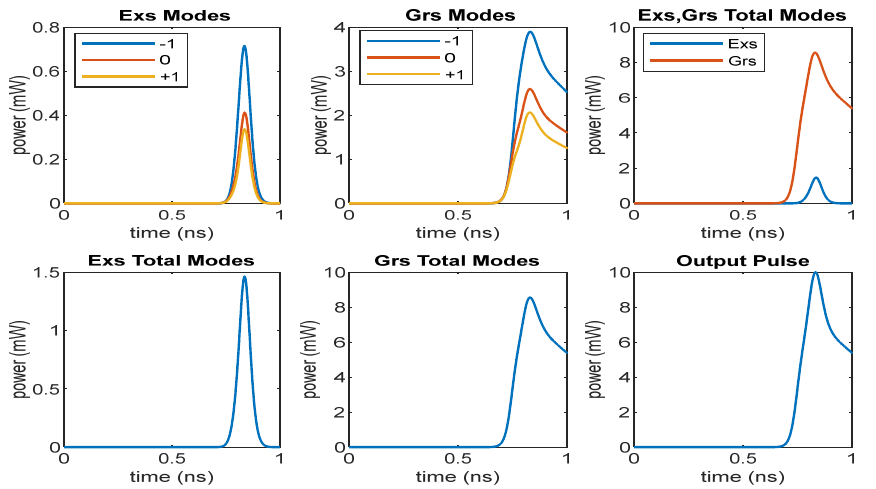
Figure 9. Output pulses for an I rf current of 25 mA for Γ ihom = 55 meV.